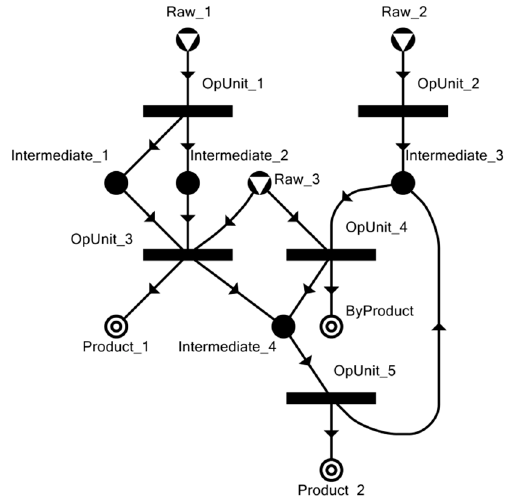
Figure 1. Example P-Graph with five operating units, three possible raw materials, two desired final products, and a byproduct. Note that cycles are possible in P-Graphs.